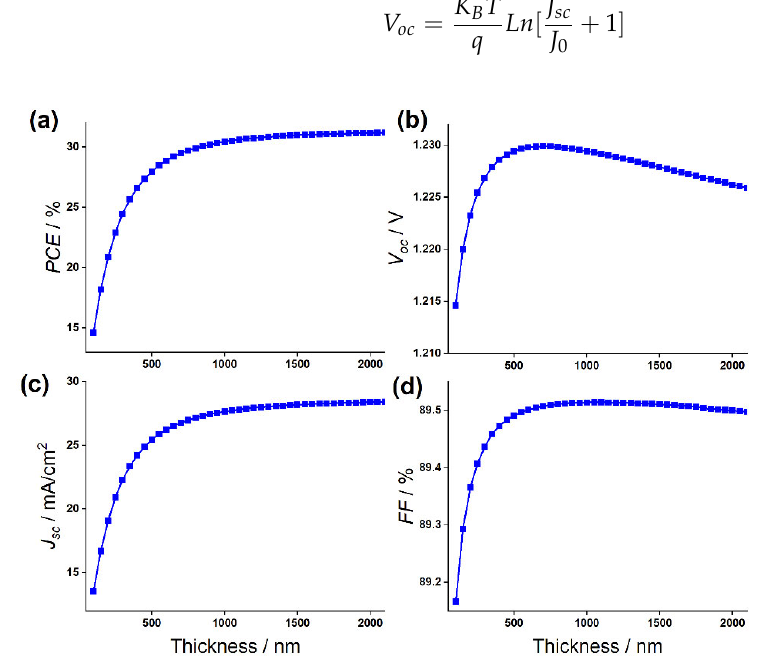
Figure 5. Change in ( a ) PCE , ( b ) V oc , ( c ) J sc , and ( d ) FF against the CsSnGeI 3 absorber layer thick- ness variation.